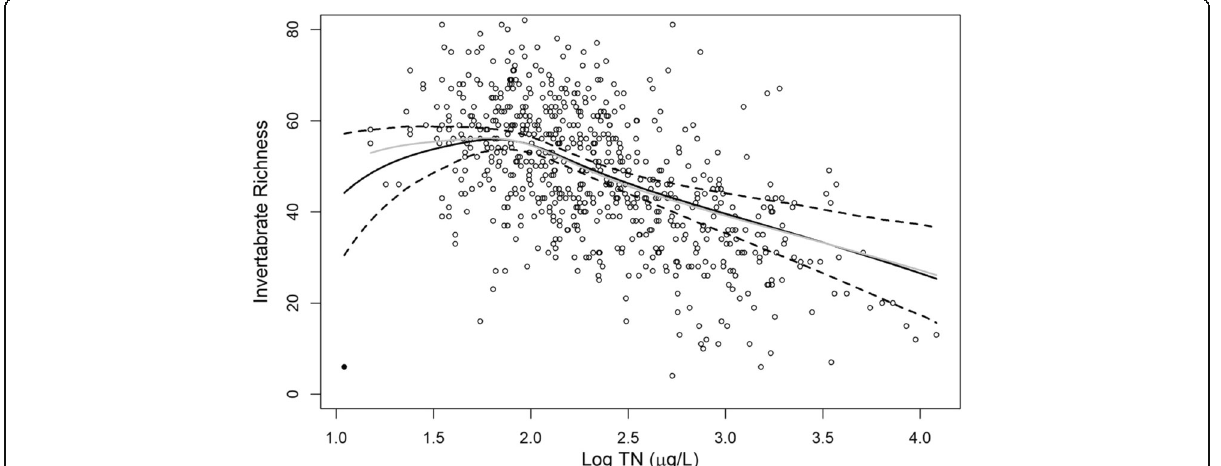
Fig. 4 Comparison between the estimated effects of total nitrogen on invertebrate richness based on the generalized propensity score with/without the “ outlier ” stream site (the black point). The black solid line and the black dashed lines are the mean estimations and the corresponding 95% confidence boundaries including the outlier, respectively. The gray line is the mean estimation excluding the